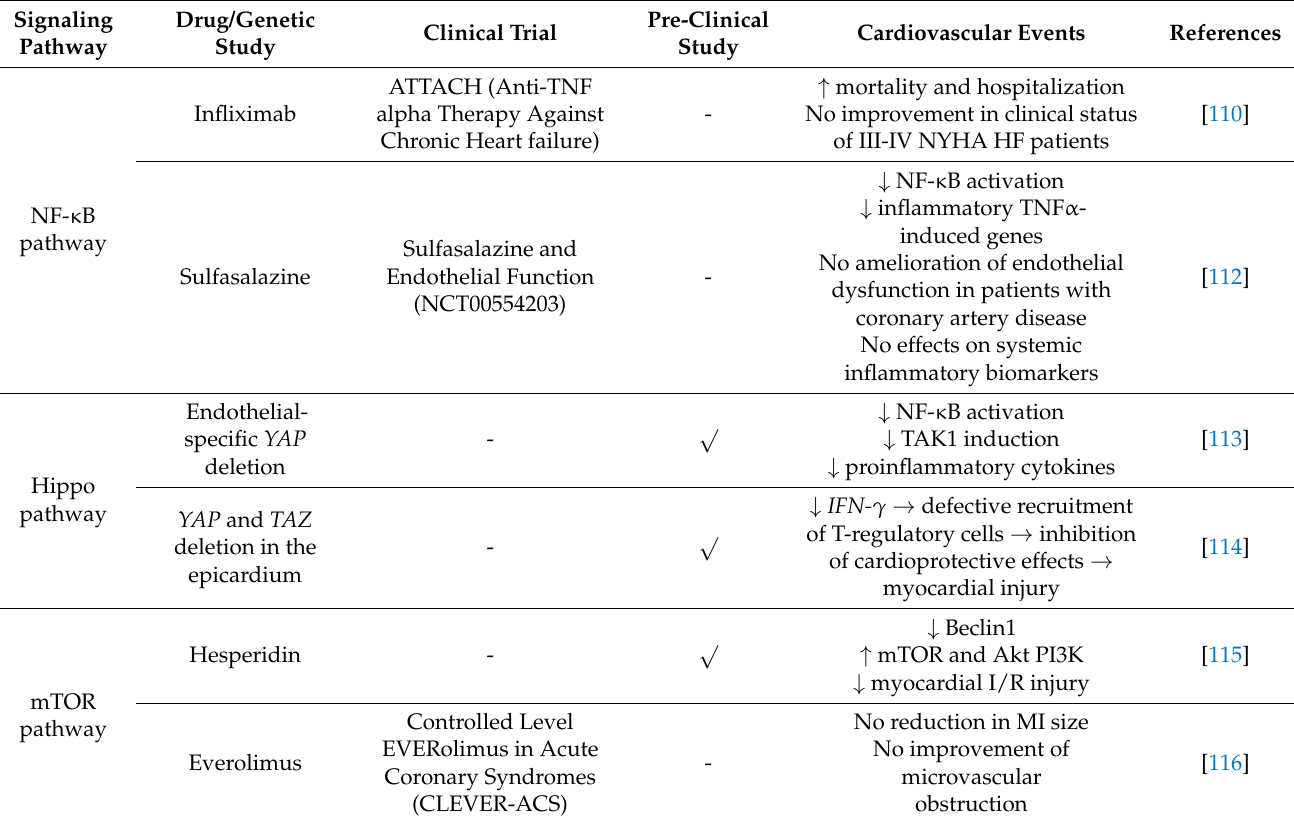
Table 2. Pre-clinical studies/clinical trials targeting signaling pathways in cardiovascular